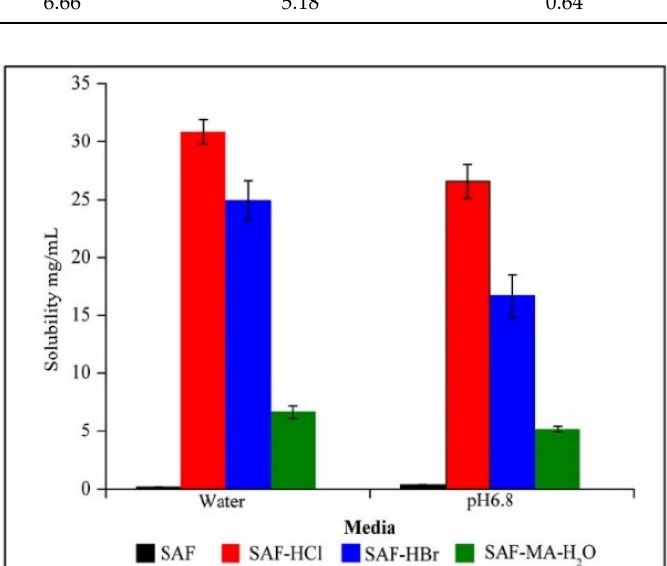
Figure 8. Solubility studies in water and pH 6.86 media. SAF, SAF-HCl, SAF-HBr, and SAF-MA-H 2 O ( n = 6).